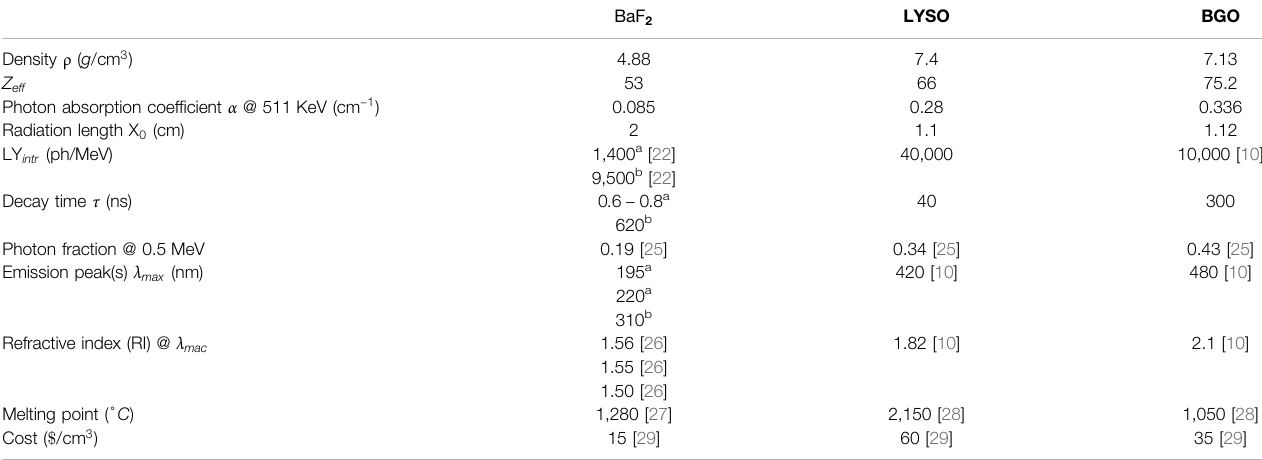
TABLE 1 | Overview of the general characteristics of Ba F 2 , LYSO, and BGO. Values are taken from the book Inorganic Scintillators for Detector Systems [19], unless otherwise